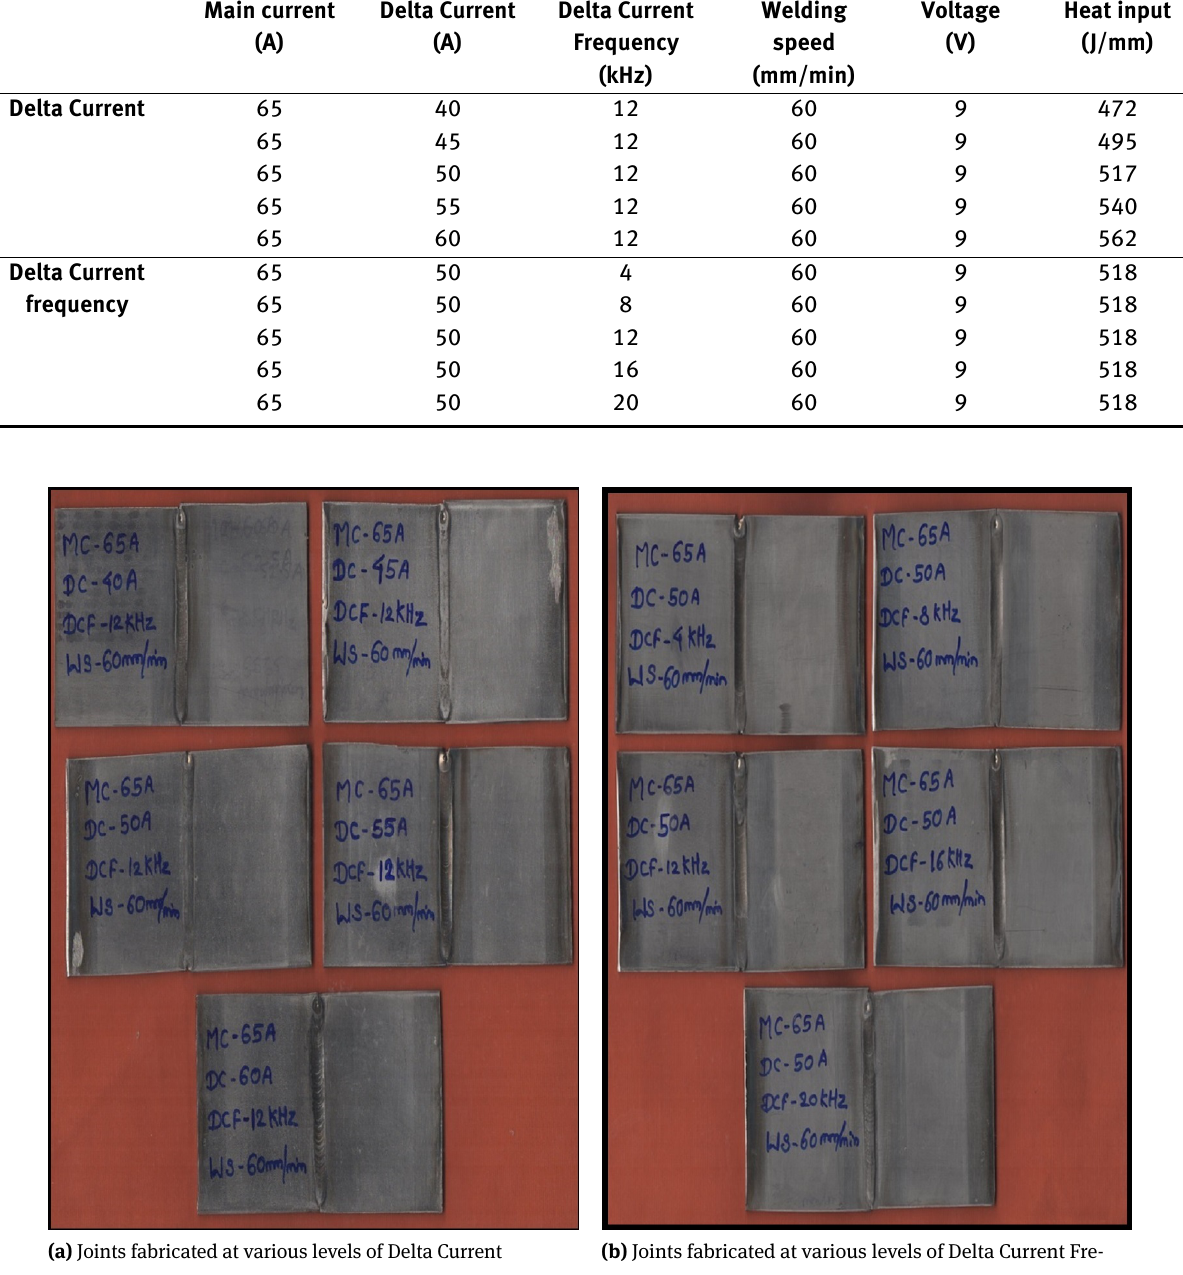
Figure 3: Photograph of welded